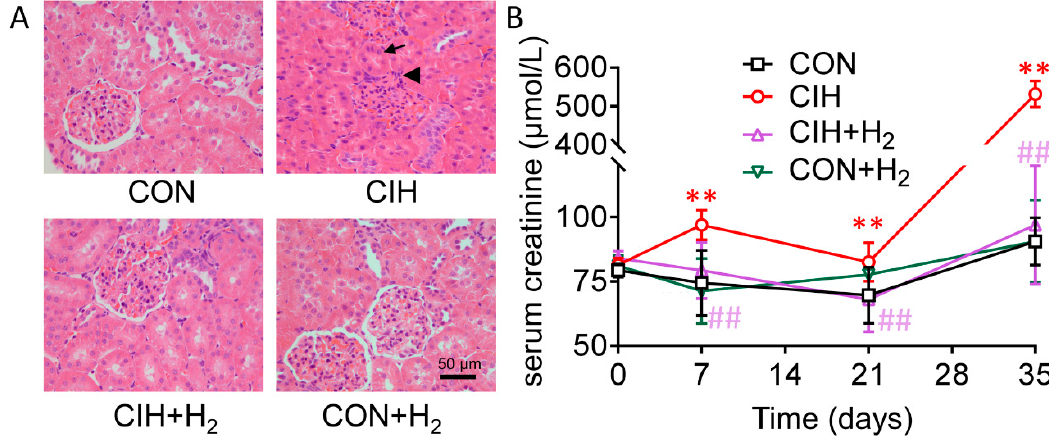
Figure 1. Effect of H 2 on the structure and function of kidney in rats exposed to CIH (chronic intermittent hypoxia) ( A ). Representative hematoxylin and eosin stained images.